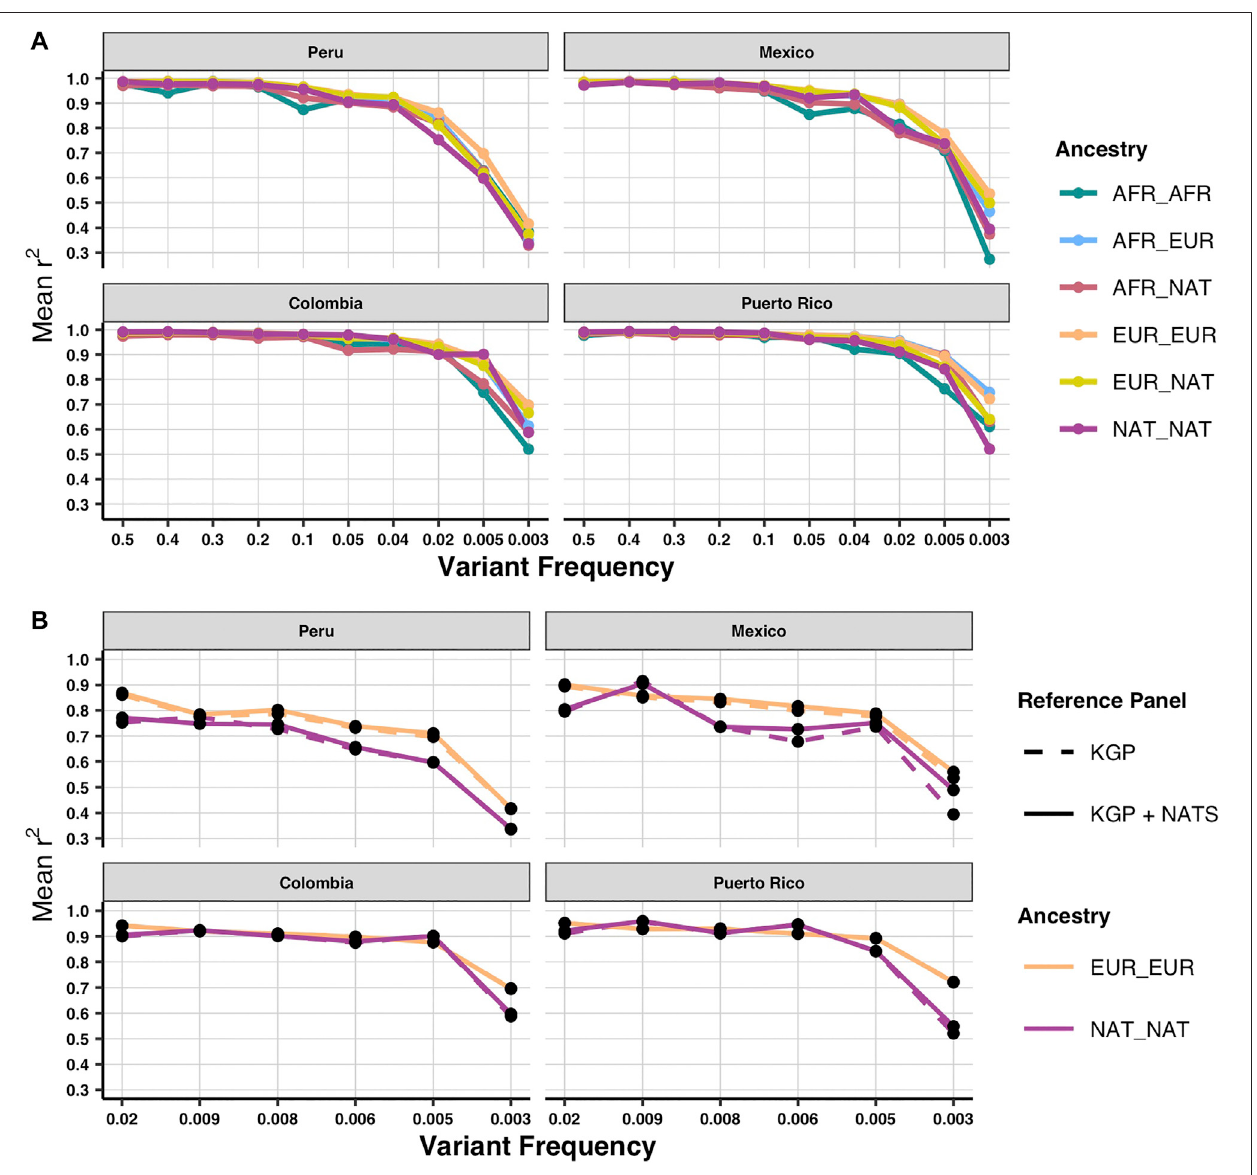
FIGURE 2 | Imputation accuracy by local ancestry and population using both reference panels. (A) Imputation accuracy of the four AMR populations strati fi ed by diploid localancestryfortheMEGAarrayusing1KGPasreferencepanel. (B) ImputationaccuracyfortheNativeandEuropeandiploidancestriesusing1KGPand1KGP + NATS asreference panel focusing on rare alleles. Imputation accuracy was calculated with the Pearson squared correlation between imputed and real allele dosages.